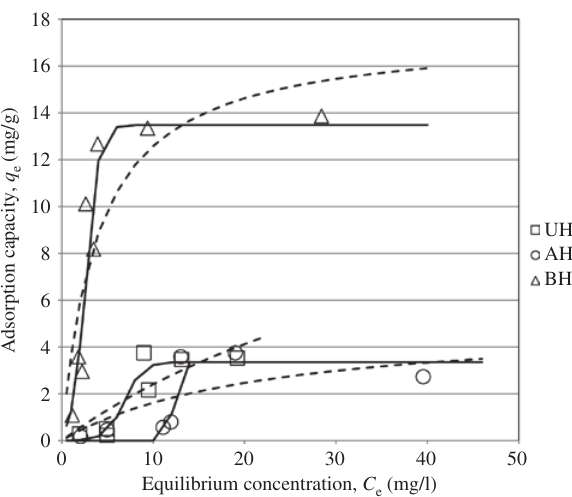
Figure 3: Equilibrium adsorption of methylene blue onto human hair adsorbents (lines were predicted by, solid: S-shaped isotherm; dashed: Langmuir